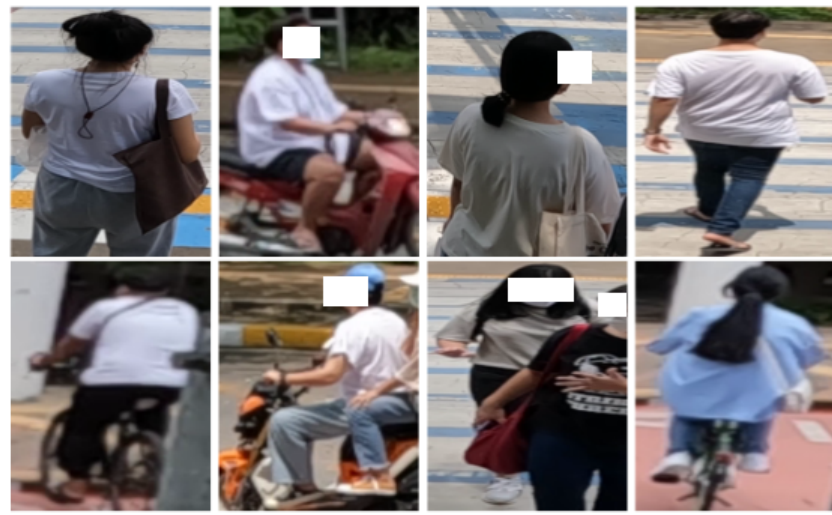
Figure 9. The search result using the description “white t-shirt women